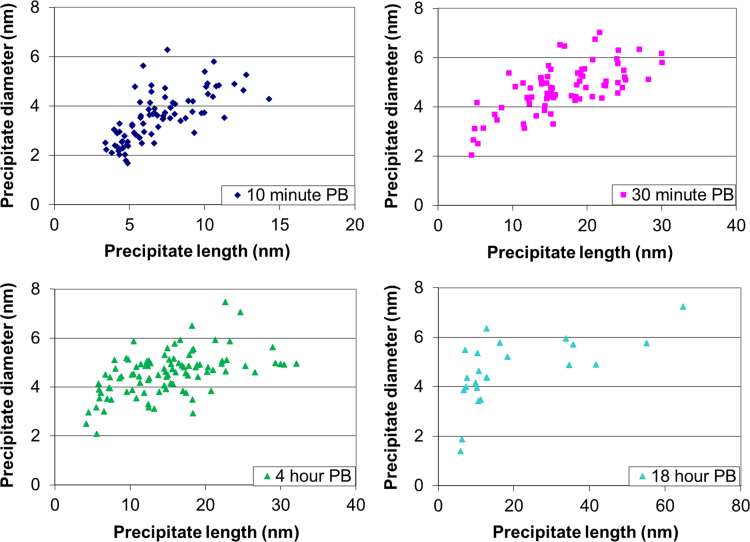
Measured diameters of precipitates plotted against precipitate length after various PB treatments at 453 K.